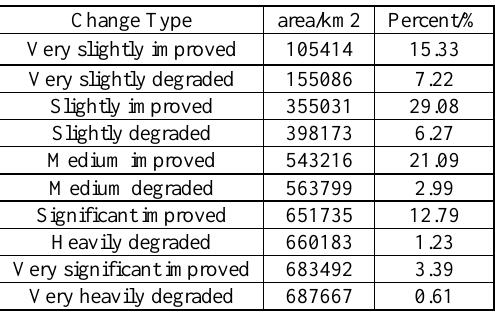
Figure 8. The vegetation coverage change trend during the period from 2000 to 2012 in Qinghai province